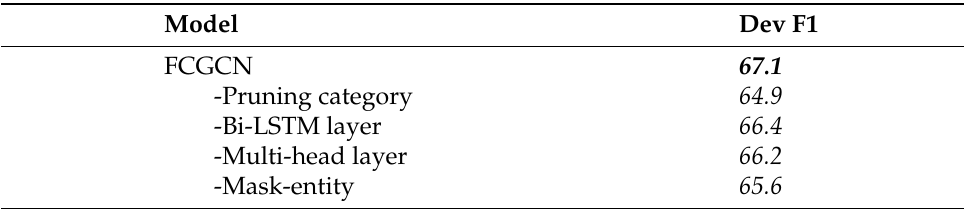
Table 4. Ablation study on